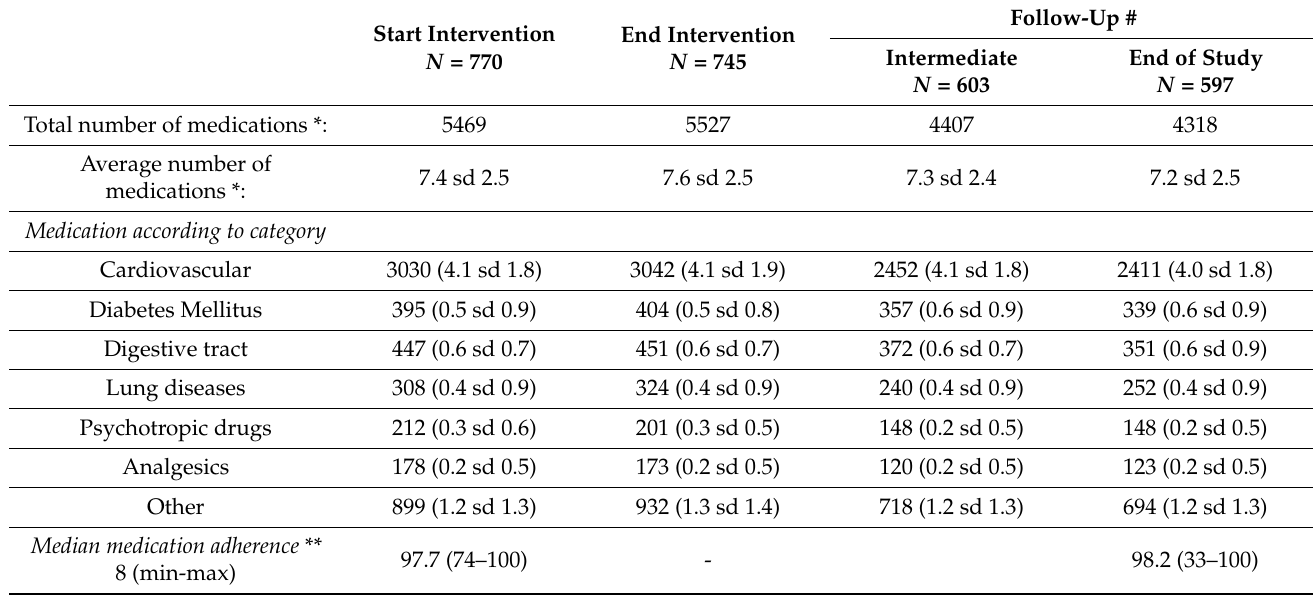
Table 5. Analysis of number of medications.